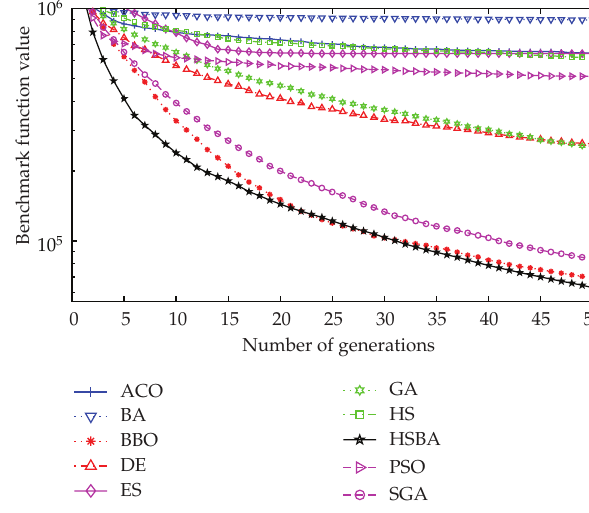
Figure 2: Comparison of the performance of the different methods for the F02 Fletcher-Powell